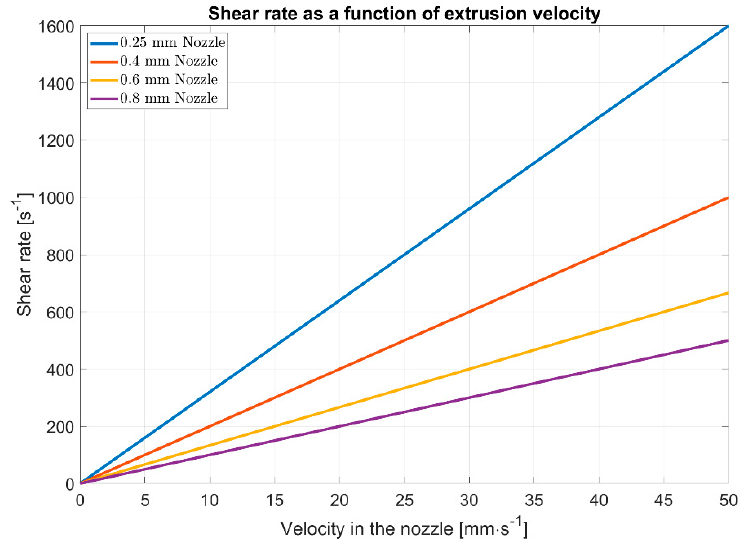
Figure 4. Shear rates in fused filament fabrication (FFF) related to different nozzle